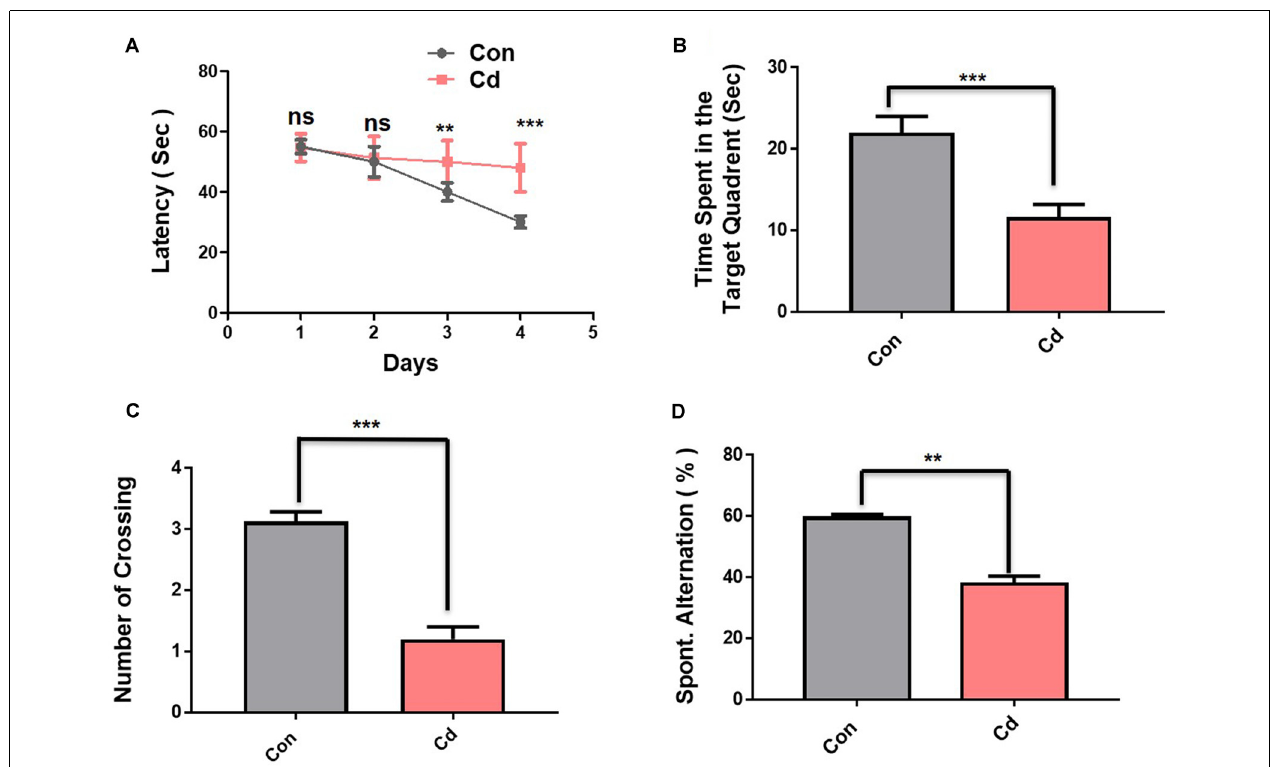
FIGURE 2 | Cd exposure accelerated memory impairment in mice. The behavioral studies were performed through MWM and the Y-maze test. The mice (12 mice per group) were used for the behavioral analysis. (A) The time it took [escape latency (sec)] to reach the submerged hidden platform during training. (B) The graphs represent the duration spent in the target quadrant (where the platform was located during the hidden platform training session) during the probe test. (C) The number of platform crossings during the probe test. (D) The graphs represent the % of spontaneous alternation behavior in the Y-maze test. The escape latencies in the behavioral tests were analyzed using a two-way ANOVA, with training days as the repeated measurements, while for other probe tests and Y-maze test, the Student’s unpaired t -test was used. The graphs express the means ± standard error of the mean (SEM; n = 12 mice/group). Significance = ** p < 0.01, *** p < 0.001; ns =